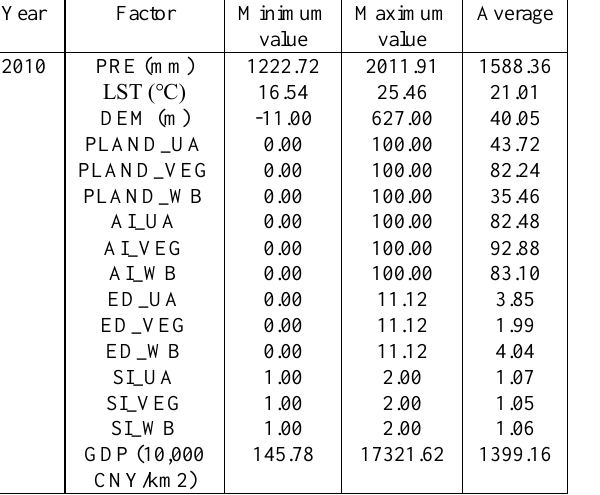
Table 6. Details of impact factors in 2010.